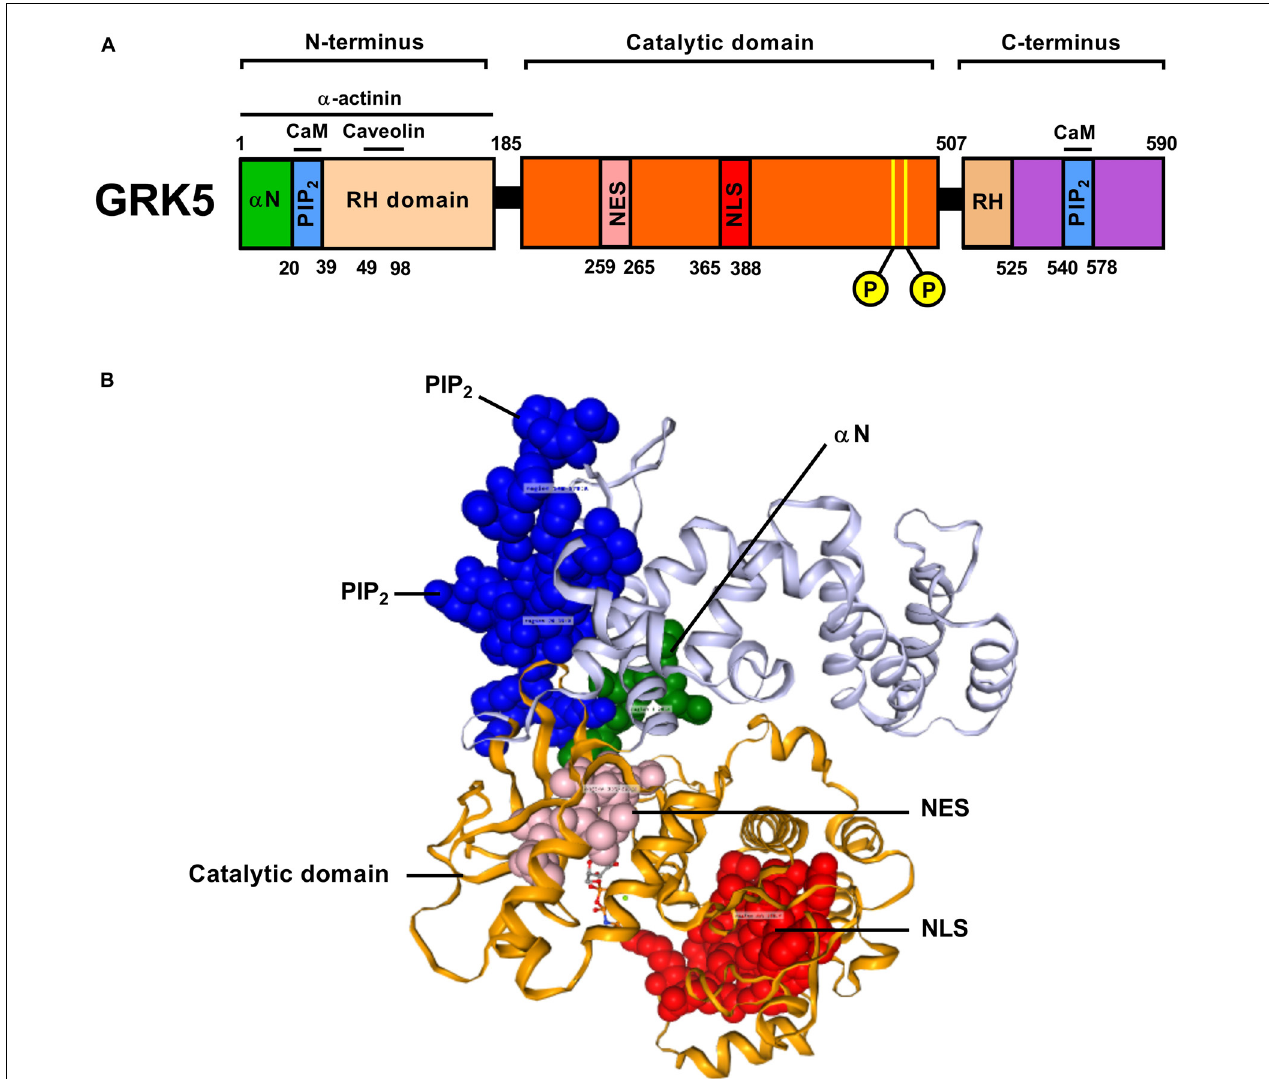
FIGURE 1 | A graphical block depiction (A) of the multiple functional regions of human GRK5 indicates the diverse range of activities mediated by this protein ( α -N, terminal domain; PIP2, phosphatidylinositol bisphosphate binding domain; RH, Regulator of G protein signaling homology domain; NES, Nuclear Export Sequence; NLS, Nuclear Localization Sequence). In the primary sequence two autophosphorylation sites are indicated within the catalytic domain. A crystal-assisted model of human GRK5 (B) was constructed and annotated using 3DBionotes-WS (http://3dbionotes.cnb.csic.es/ws). This model indicates the three-dimensional proximities of the α -N domain (green), PIP2 binding domains (blue), NES (pink), catalytic domain (orange), and the NLS domain